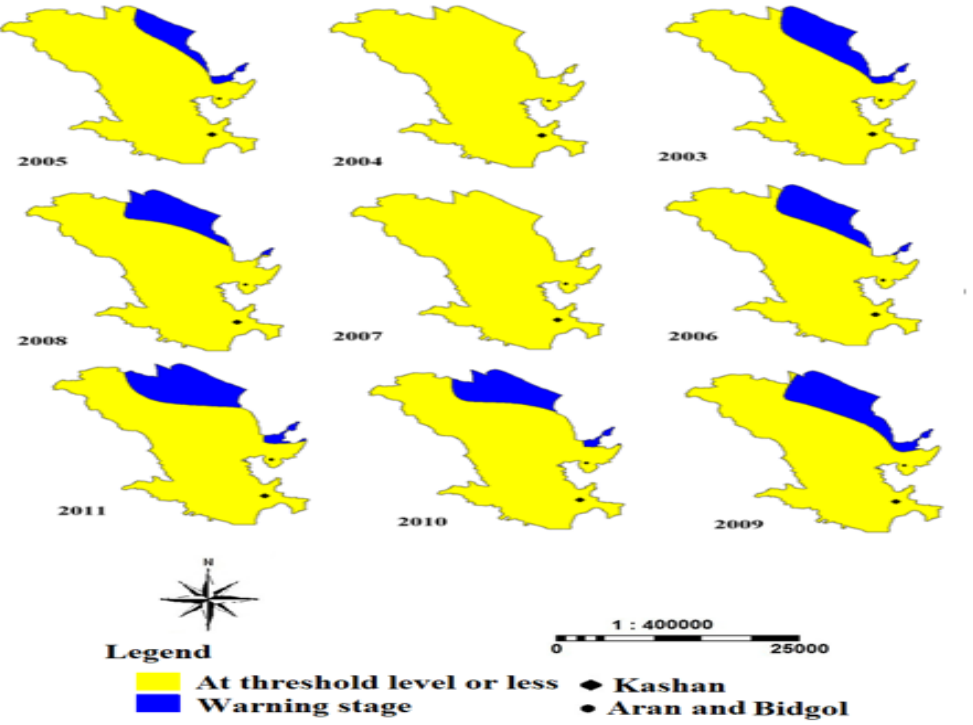
Figure 9. The areas under warning stage based on SAR (2003-2011)